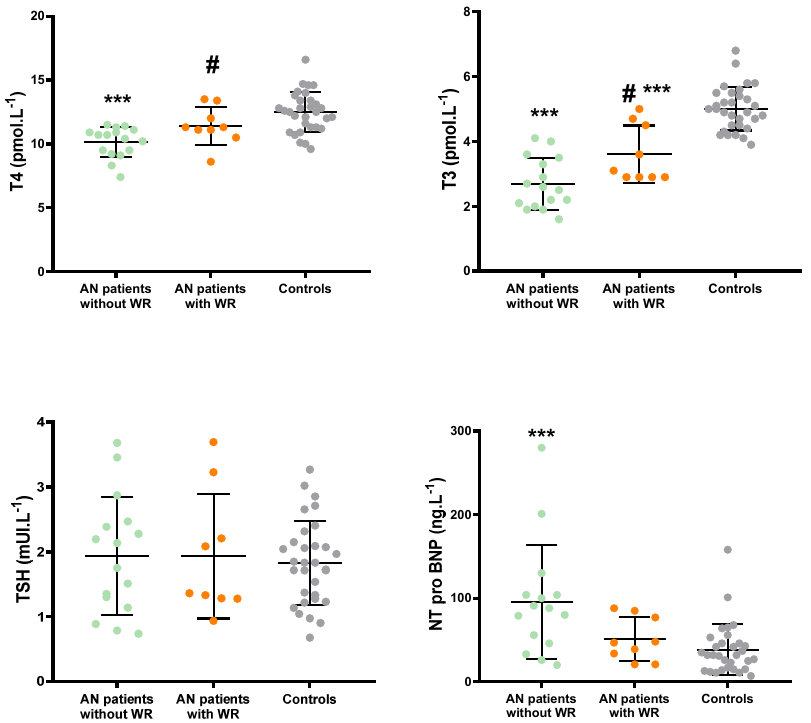
Figure 2. Biological data of AN patients (with, in orange, and without WR, in green) and con- trols (in grey): T4, T3, TSH and NT-proBNP. ***: significantly different from Controls ( p < 0.001); # : Significantly different from AN patients with WR ( p <